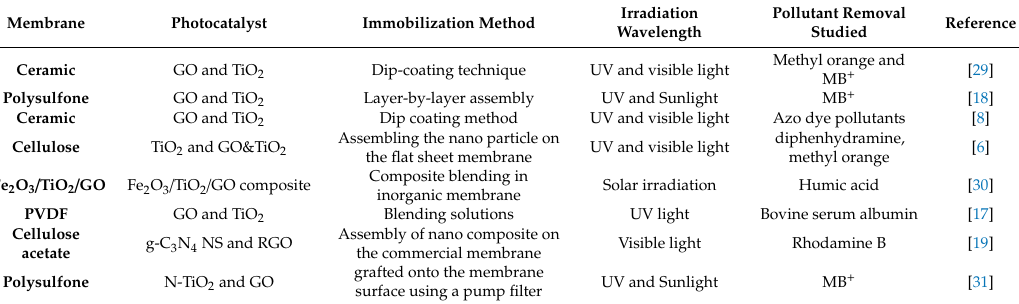
Table 1. Membranes containing photocatalysts for pollutants’